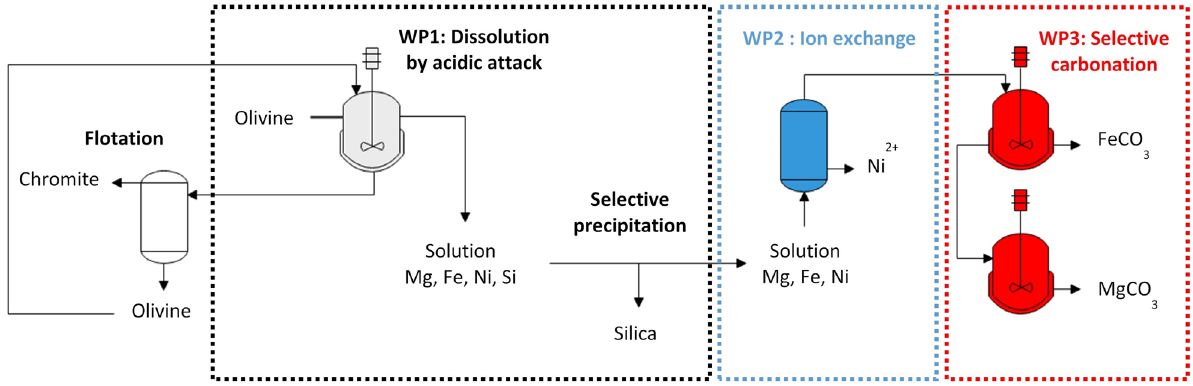
sequestration by indirect carbonation of 2